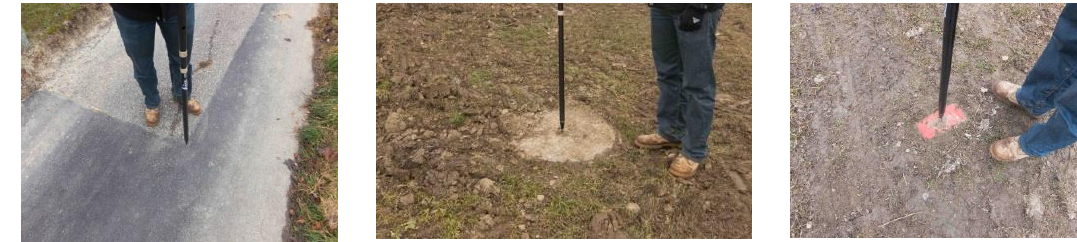
Figure 4. Traditional orthogonal flight plan and 2 perpendicular directions flight plan on quite a homogenous surface.